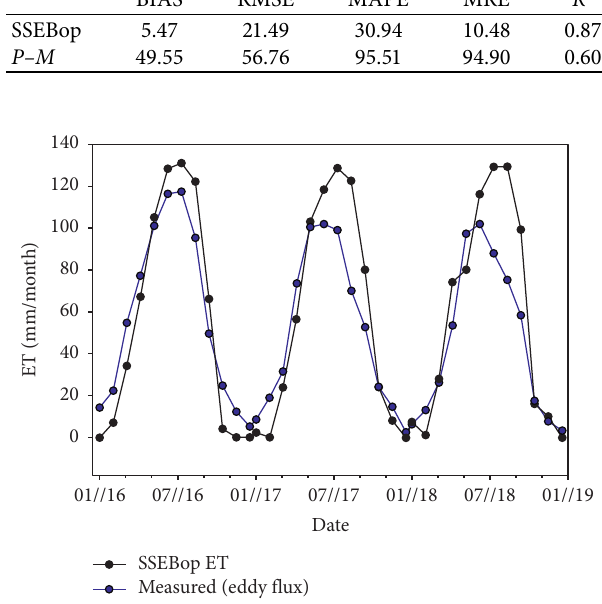
Figure 3: Monthly total (mm month − 1 ) estimated by SSEBop (black) and measured ET (blue) during 2016–2018.